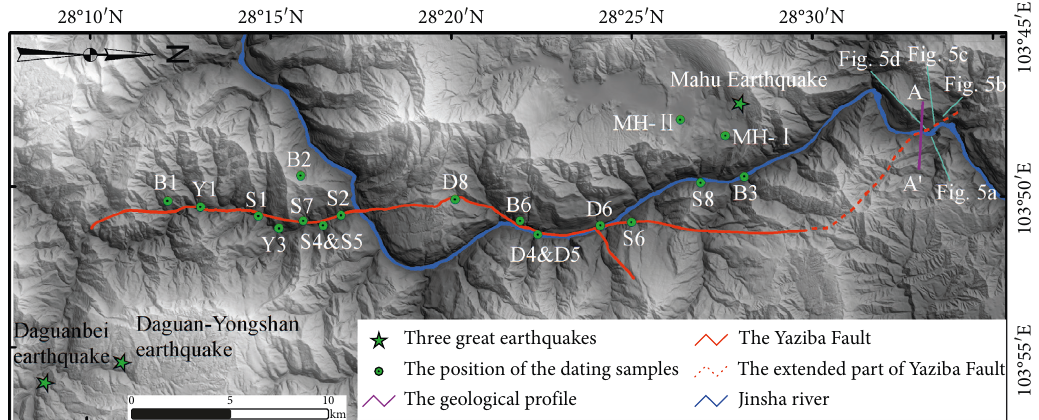
Figure 4: Map showing the Yaziba Fault, the sampling sites for dating, and the epicenter of three great earthquakes with M